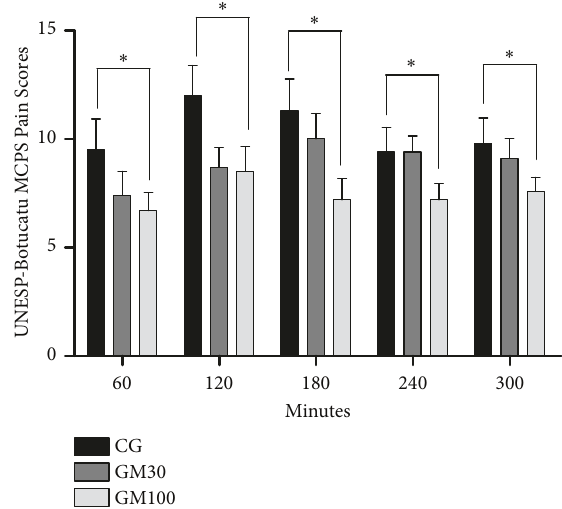
Figure 1: Mean ± standard error of the mean scores for the UNESP- Botucatu multidimensional composite pain scale (MCPS) in cats following ovariohysterectomy. ∗ Pain score different between the control group (CG) and the group receiving maropitant 100 𝜇 g/kg/h (GM100) throughout postoperative evaluation.